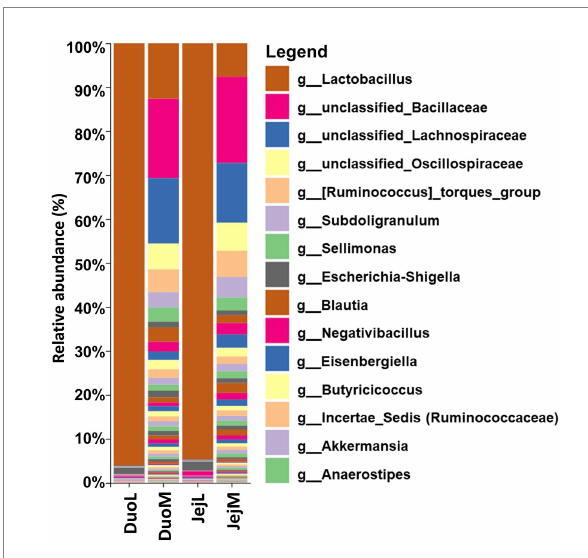
FIGURE 1 Relative abundances of bacterial taxa at the genus level in duodenal luminal (DuoL), duodenal mucosal (DuoM), jejunal luminal (JejL), and jejunal mucosal (JejM) microbiota ( n = 48 samples for each column). The 15 most abundant taxa overall are indicated in the legend.